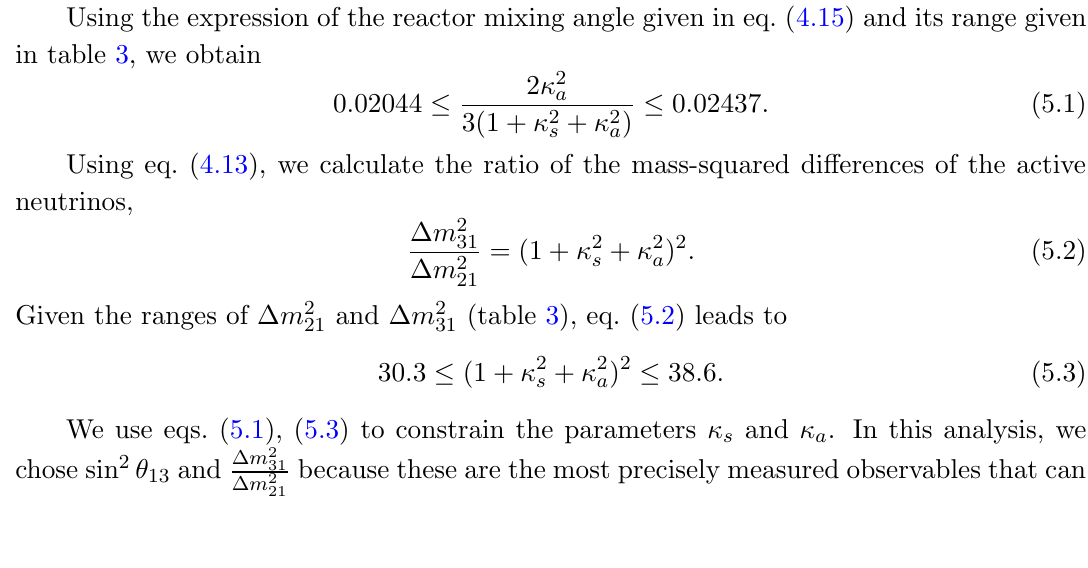
Figure 1 . The parameters (cid:20) s and (cid:20) a constrained using the reactor mixing angle and the ratio of the mass-squared di(cid:11)erences of the active